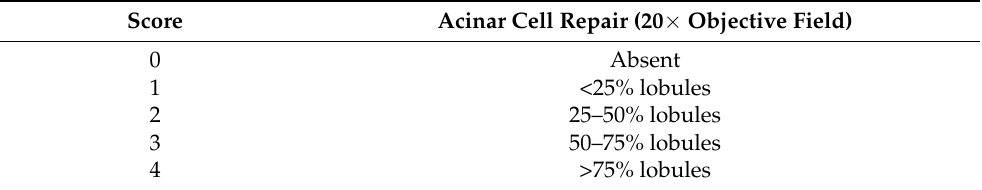
Table 2. Histological scoring system for recovery phase in mice with cerulein-induced acute pancre- atitis (2–7 days) after initial